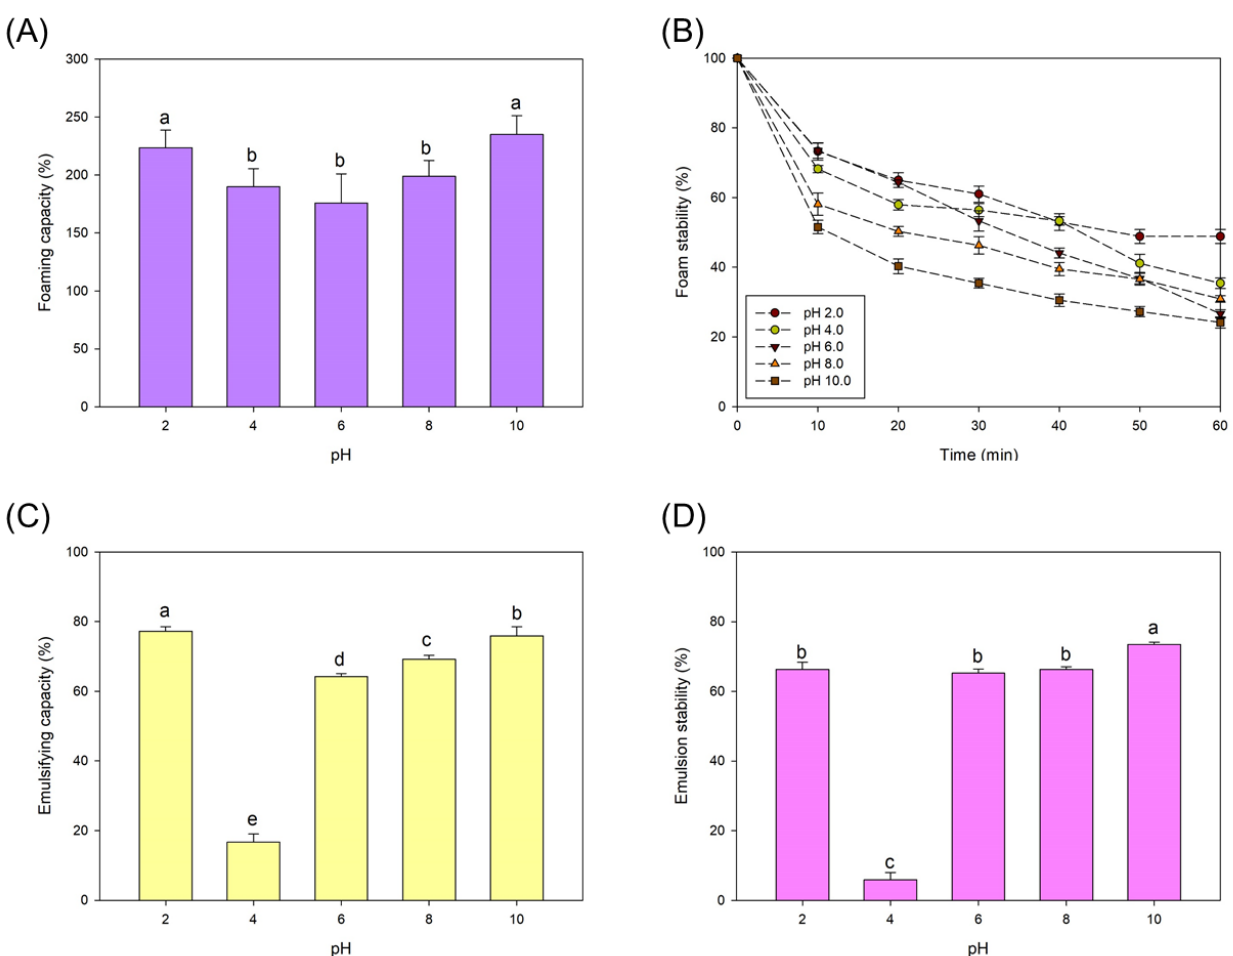
Figure 4. ( A ) Foaming capacity, ( B ) foam stability, ( C ) emulsifying capacity, and ( D ) emulsion stability. Different letters indicate significant differences ( p < 0.05).